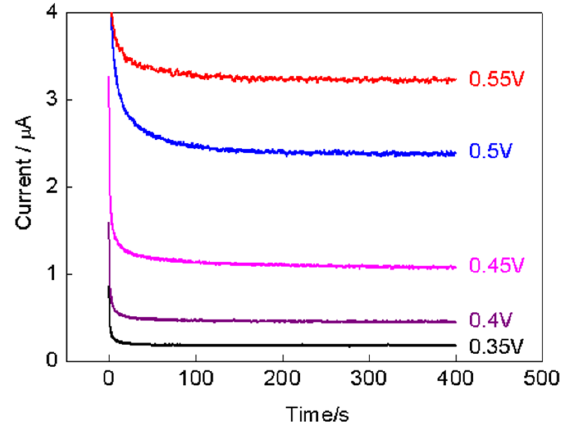
Figure 6. Current-time curves for PPy-RGO-(AuNPs-GOD) 4 /GCE in 4 mM glucose at different applied potentials from 0.35 V to 0.55 V versus SCE.